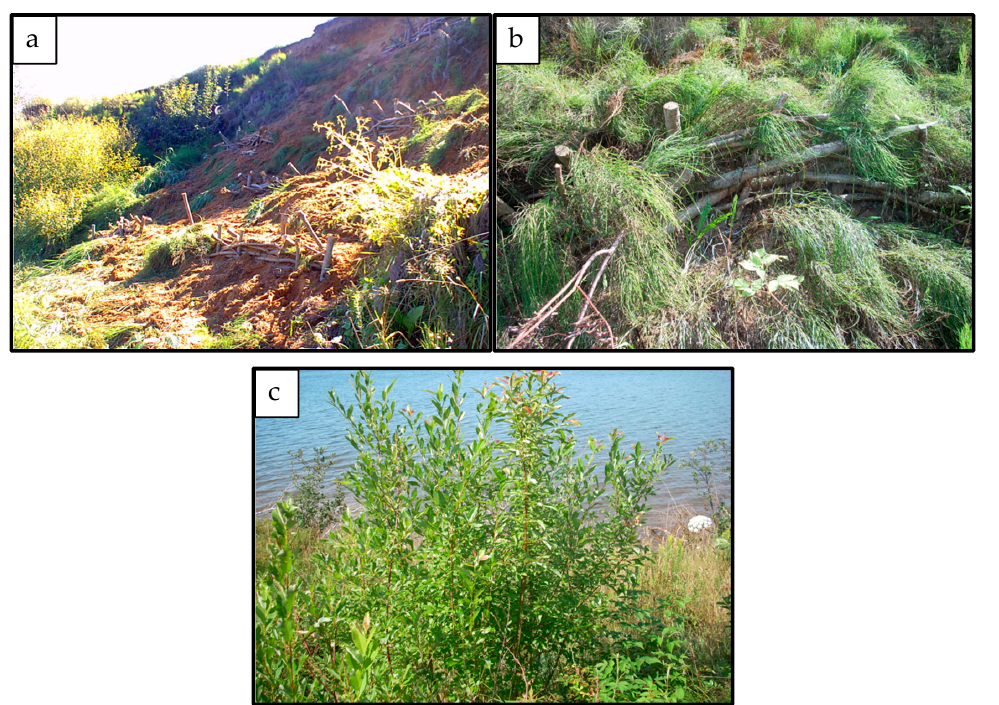
Figure 4. Restoration of an erosion site using live staking. ( a ) sill boxes installed on an eroding bank for the live staking process; ( b ) vegetative regrowth on the slope 5 years after restoration; and ( c ) willow growth from live staking process 5 years after restoration.